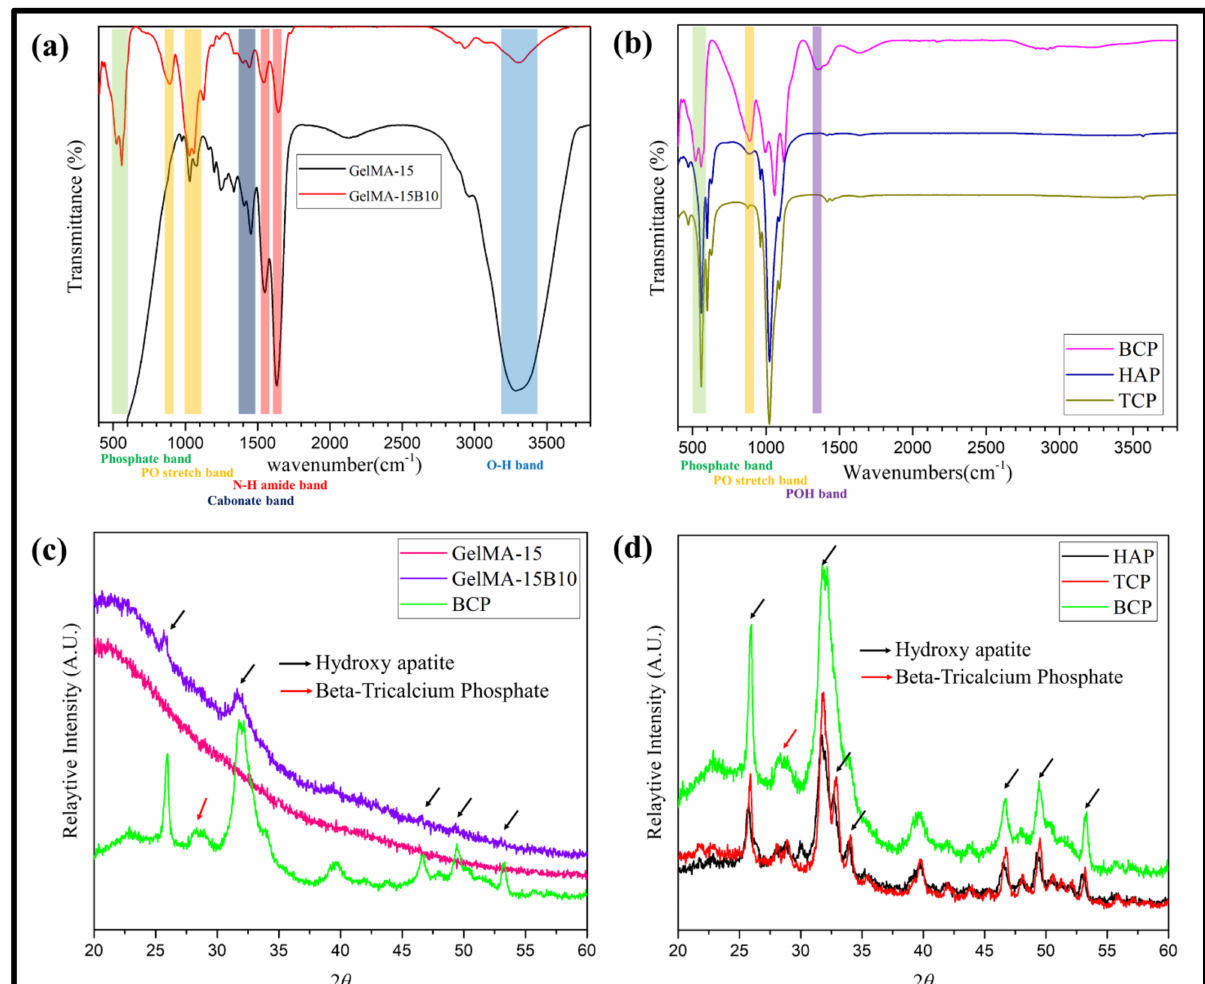
Figure 2. FTIR and XRD analysis of hydrogels (GelMA-15, GelMA-15B10, BCP-NP) and Nano-particles (BCP-NP, HAP, and TCP); FTIR; ( a ) hydrogels, ( b ) nano-particles/XRD, ( c ) hydrogels, and ( d )